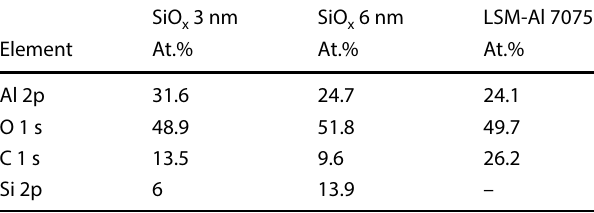
Table 1 Surface chemical composition determined via XPS survey quantification in the laser surface melted state and additionally covered with a 3 nm and a 6 nm PECVD SiO -film x SiO 3 nm SiO 6 nm LSM-Al 7075 x x Element At.% At.% At.% Al